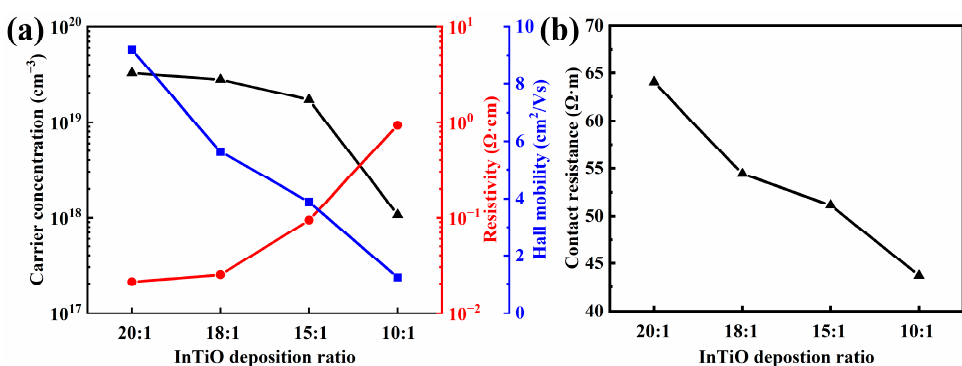
Figure 6. ( a ) The carrier concentration, resistivity, and Hall mobility of InTiO x films deposited on glass substrates. ( b ) The changing trend of contact resistance with doping ratios.